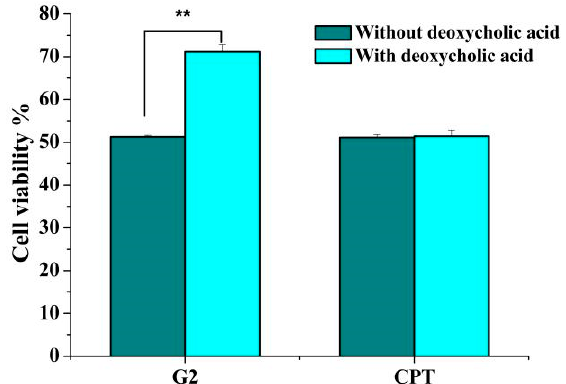
Figure 2. The effect of deoxycholic acid on cytotoxicity of G2 and CPT. After pretreatment with 1 μ M deoxycholic acid for 0.5 h, HepG2 cells were incubated with 1 μ M G2 or CPT for 48 h and the cell viability was detected. Results are presented as mean ± SD of three independent measurements. ** p < 0.01 compared with control group.